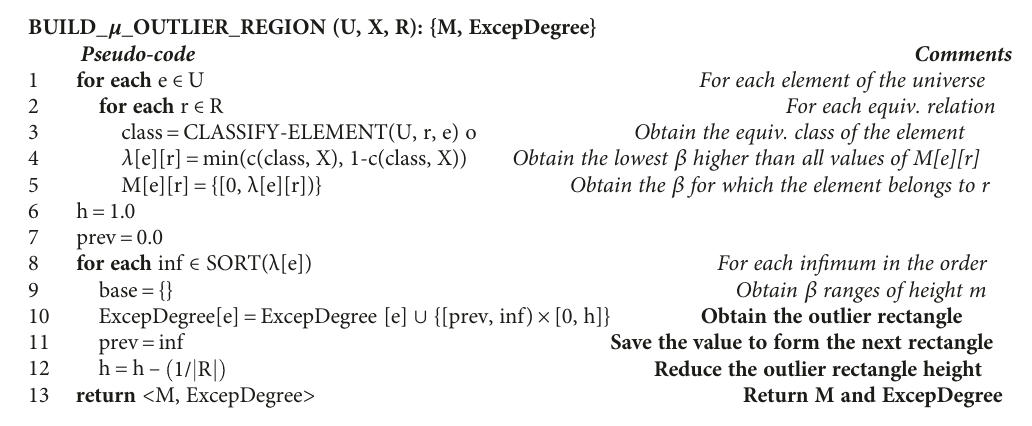
Algorithm 2: Pseudo-code of the BUILD_ μ _OUTLIER_REGION